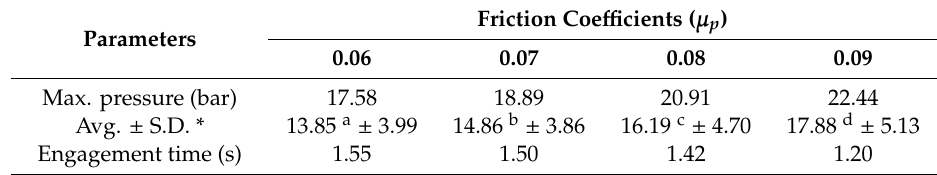
Figure 13. The piston pressures at different friction coefficients. Table 6. The piston pressures at different friction coefficients.